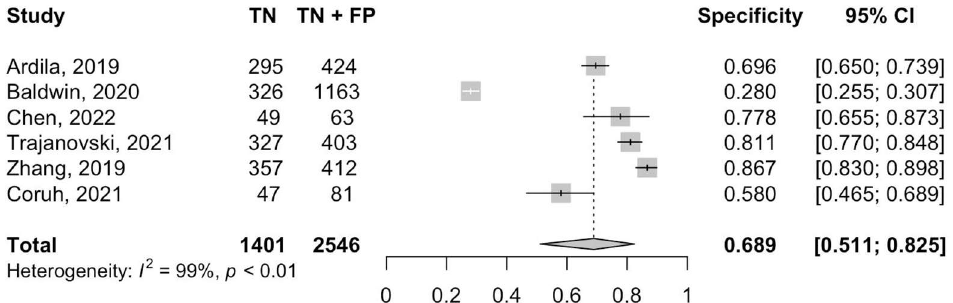
Figure 3. Forest plot of the pooled specificity of DL in the detection and classification of lung cancer [37–42].